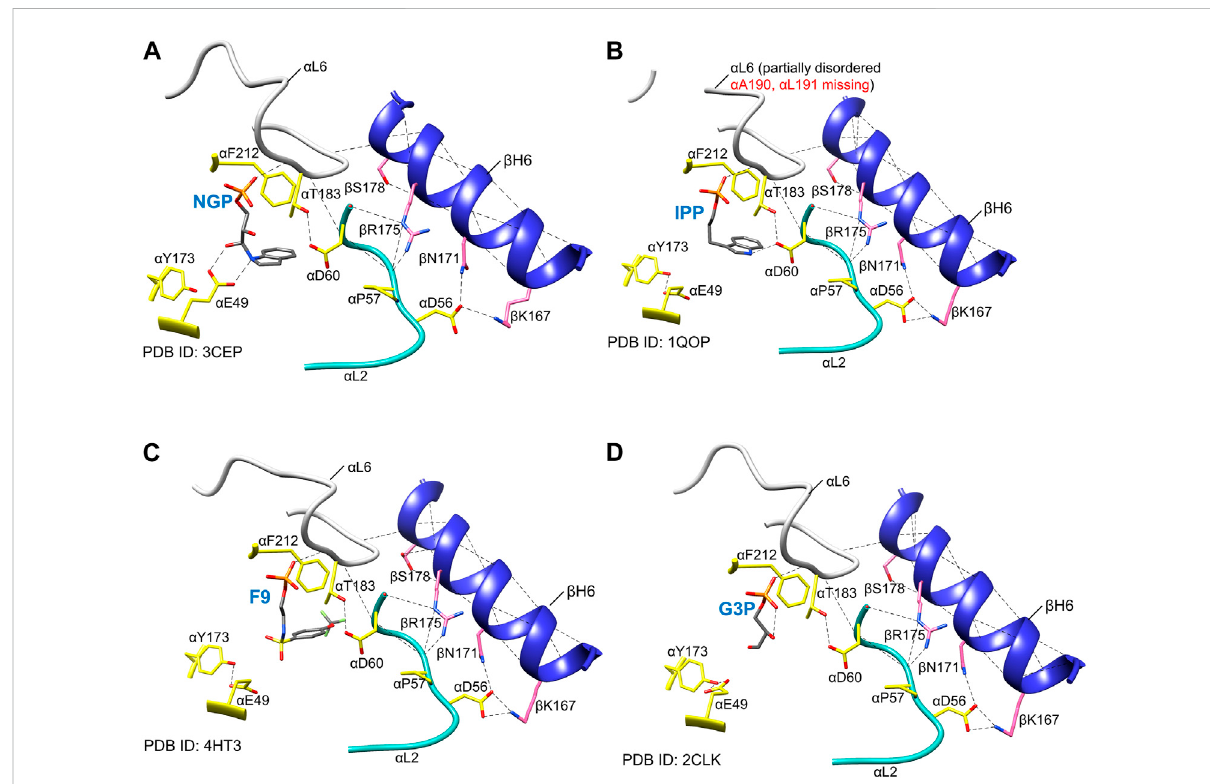
FIGURE 8 Examples of the positioning of α active site residues, αβ contacts and order in loop α L6 in the presence of different α site ligands. (A) NGP ( 15 ) (Kulik et al., 2005), (B) IPP ( 13 ) (Hyde et al., 1988), (C) F9 ( 8 ) Ngo et al., 2007a, (B) , (D) product G3P ( 6 ) (Ngo et al., 2007a). Notice that the α E49 side- chain points away from the α site ligands in each of the panels, whereas α D60 side-chain H-bonds to the aromatic nitrogen (N-1) atom of the IGP analogIPP,asdepictedinFigures2A,6,itwouldplayacentralroleinIGPcleavage. α F212isrotatedtowardstheligand,providingahydrophobic environment for the cleavage. Notice that NGP has been proposed to be a transition state analogue for the α -site catalyzed cleavage of IGP (Kulik et al., 2005). The essential hydrogen bonding interaction between α Thr183 and α Asp60 is shown together with those between α L2, α L6, and β H6. Coloringscheme:proteinsidechains,yellowsticks;loop α L6,whiteribbon;loop α L2,tealribbon;helix β H6,blueribbon.The α siteligandsareshown as sticks in CPK colors; plausible H-bonds, black dashed lines. Image rendered in Chimera 1.15 (Pettersen et al.,